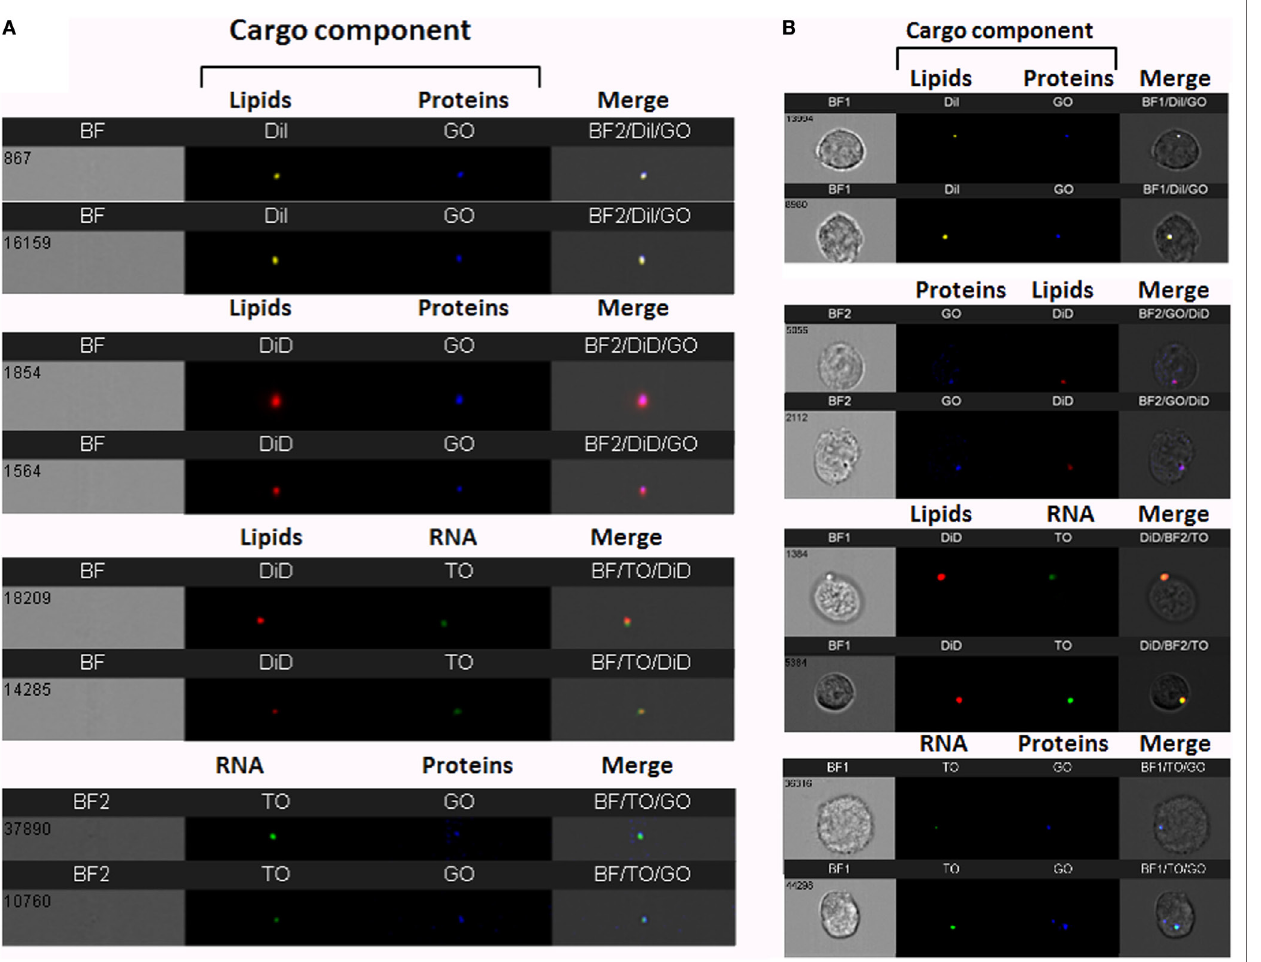
FIgURe 2 | Visualization of double-stained Plasmodium falciparum ( Pf )-derived extracellular vesicles (EVs) by imaging flow cytometry (IFC). (A) IFC analysis of double-stained Pf -derived EVs. Pf -derived EVs co-labeled with different combinations of two stains: for lipids (DiI, DiD, or DiO), RNA [thiazole orange (TO)], and proteins (GO). Representative results from at least three experiments are shown. Abbreviations: BF, bright field; SSC, side scatter (B) Uptake assay of Pf -derived EVs into monocytes (THP-1). IFC imaging of Pf -derived EVs labeled with two stains for lipids (DiI, DiD, or DiO) and/or RNA (TO) and/or proteins (GO) uptaken into THP-1 cells as described in the Section “Method.” Representative results from at least three experiments are shown. Abbreviations: BF, bright field; SSC, side